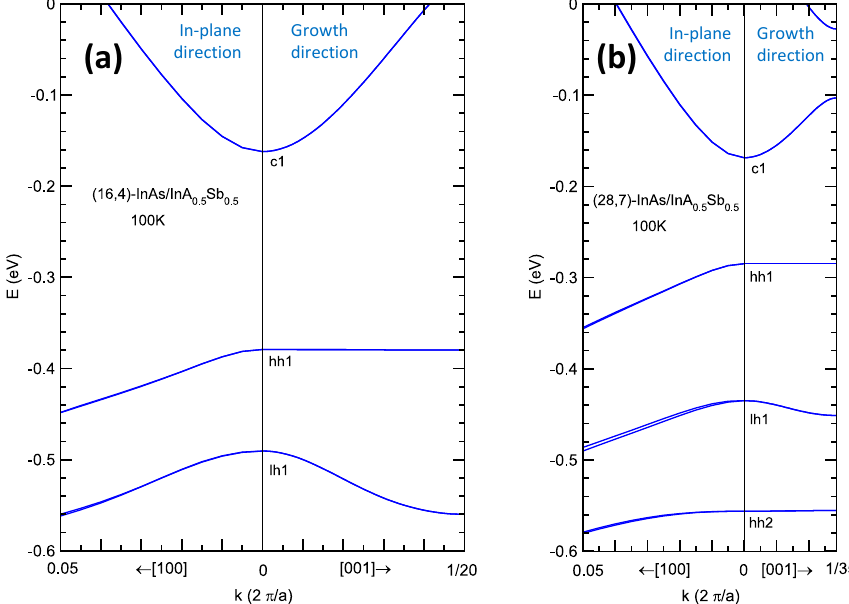
Figure 4. Energy band structure along an in-plane direction, and along the growth direction for ( a ) the (16,4)-InAs/InAs 0.5 Sb 0.5 strained-layer superlattice (SLS) ( E g = 0.217 eV; λ cutoff = 5.7 µm), and ( b ) the (28,7)-InAs/InAs 0.5 Sb 0.5 SLS ( E g = 0.116 eV; λ cutoff = 10.7 µm), on GaSb substrate at 100 K.